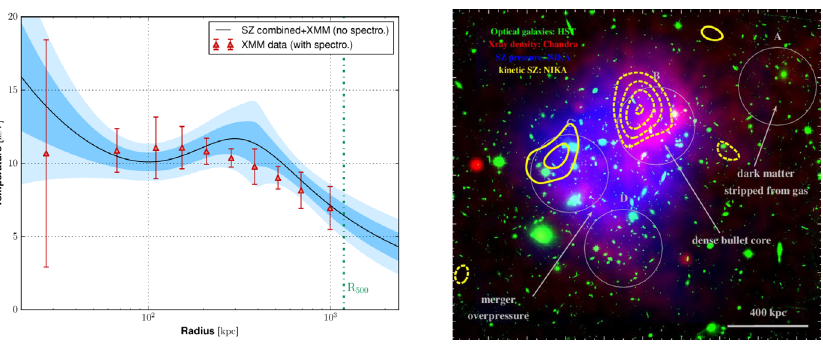
Figure 3. (left) Deprojected radial temperature profiles of PSZ2 G144.83 + 25.11( z = 0 . 58) recon- structed from the combination of the gas pressure profile derived from NIKA -2 data and the gas density profile obtained from the XMM - Newton observation. The red points trace the profile obtained from the X-ray spectroscopy. The dark and light blue regions show 68% abs 95% error envelops. The best fit is showns by a black solid line [reproduced from Fig 11 in 50]. (right) Multi-wavelength image of MACS J0717.5 + 3745 showing the galaxy distribution (green, Hubble Space Telescope), the electron gas density (red, Chandra X-ray data), the pressure (blue, NIKA) and the kSZ signal (yellow contours, NIKA, figure below). The gray circles indicate the main sub-clusters [see 45, for